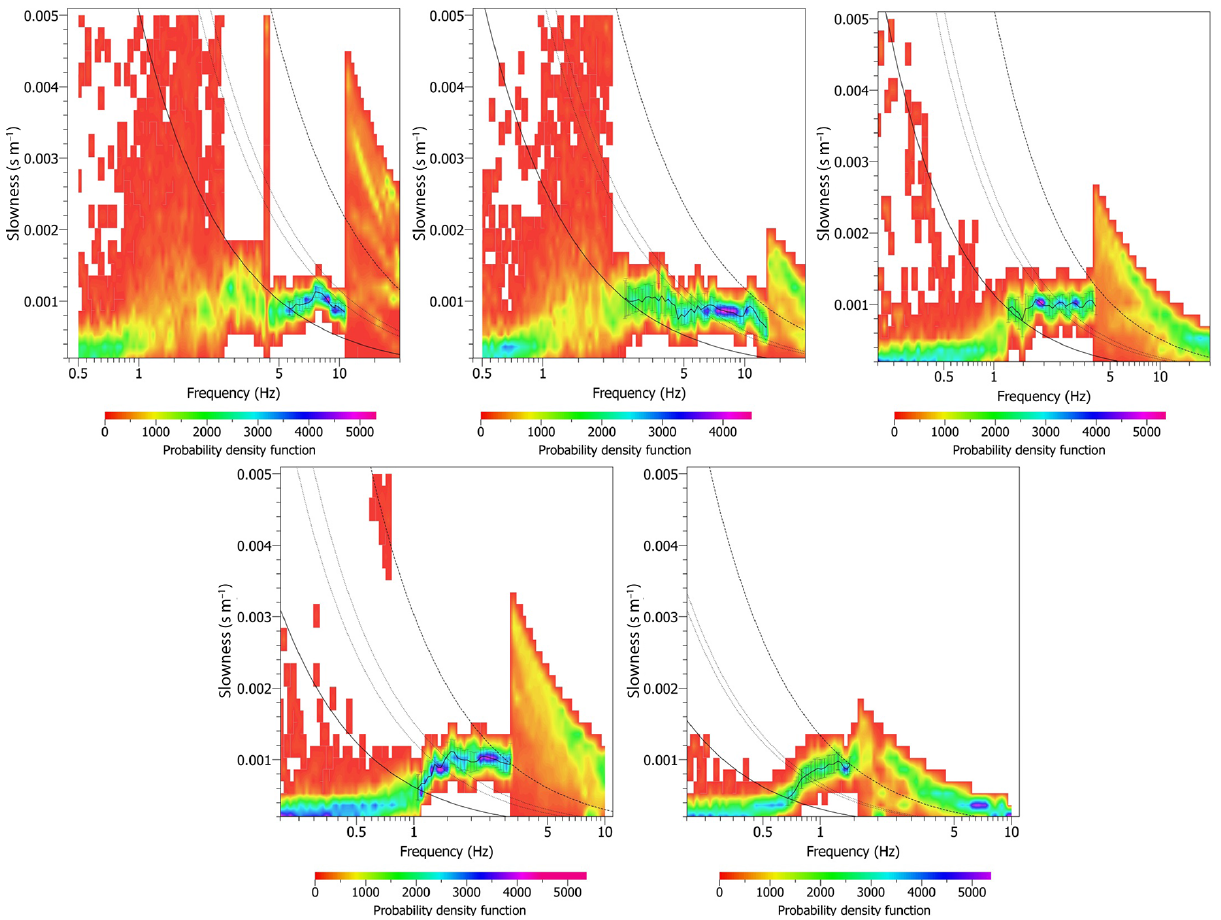
Figure 3. Histograms of velocities obtained from frequency–wavenumber analysis for each triangle configuration performed for array 1. For each plot the black line with error bars mark the dispersion curve. The continuous line indicates a constant wavenumber value of k min / 2 related to the resolution limit of this array geometry (Wathelet et al., 2008). The dashed line is a constant wavenumber value of k max that defines the aliasing limit constrained by the array geometry. The dots represent k min (left) and k max / 2